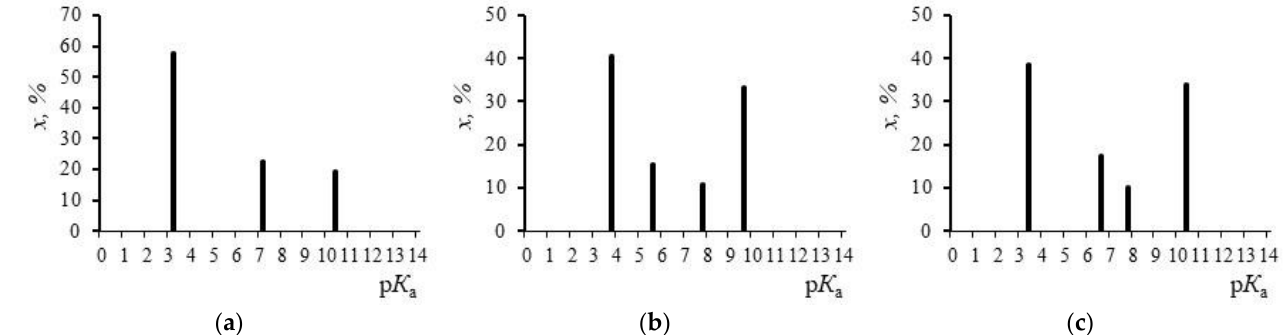
Figure 2. p K spectra of FAs isolated from the Oe horizons of Eutric Albic Stagnic Histic Retisol (Loamic) ( a ) and Eutric Albic Retisols (Loamic) virgin ( b ) and arable ( c ).